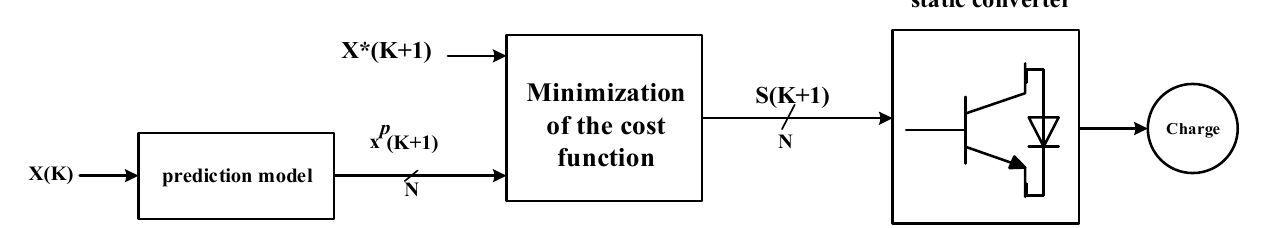
Figure 13. The general scheme of the FCS-MPC finite-state predictive control.